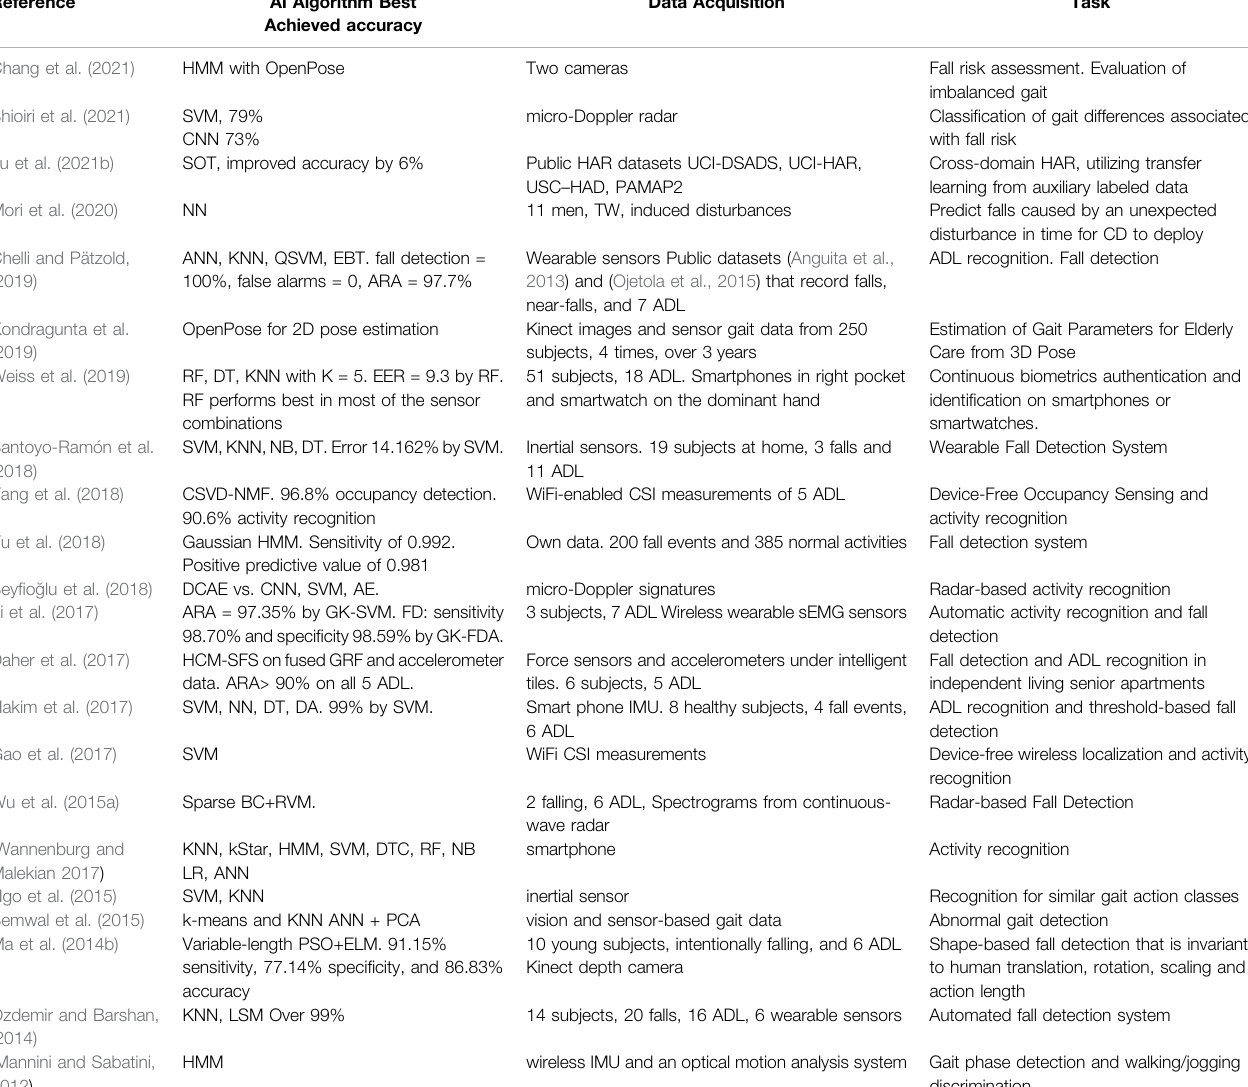
TABLE 6 | Fall detection and human activity